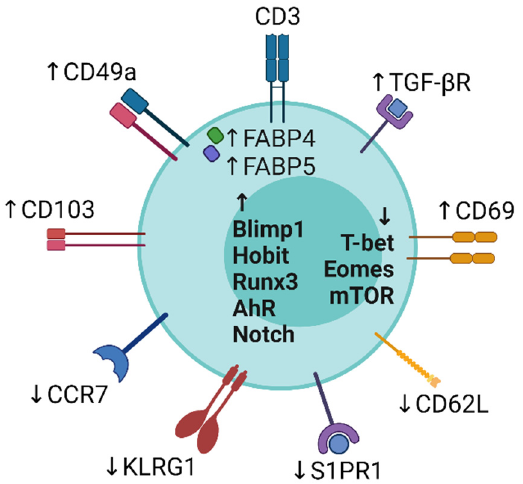
Figure 1. A. Surface markers, intracellular molecules, and transcription factors of T RM . The expression levels of these molecules on T RM are shown by upward arrows (increased expressions) and downward arrows (decreased expressions). Created with BioRender.com (accessed on 21 August 2021).